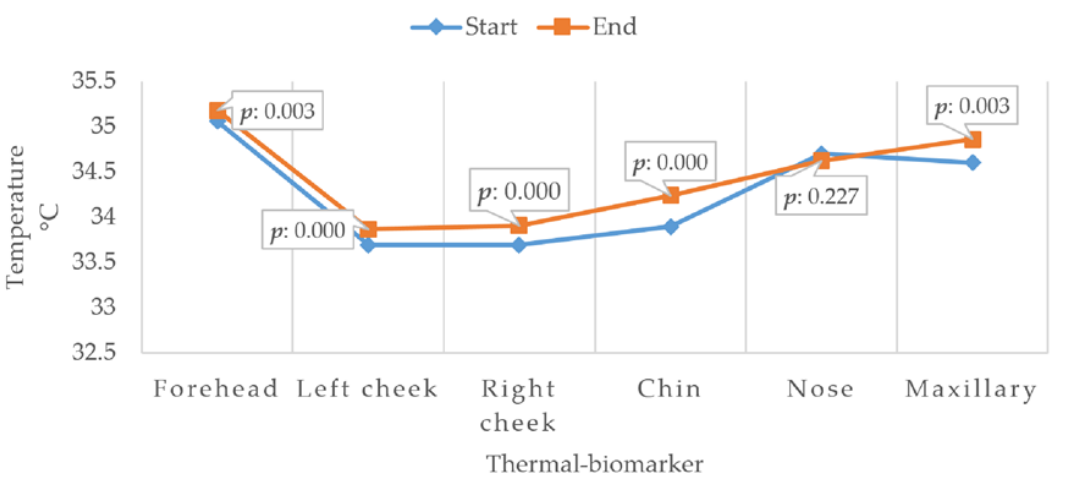
Figure 9. t-test: paired two sample for means (thermal biomarkers).